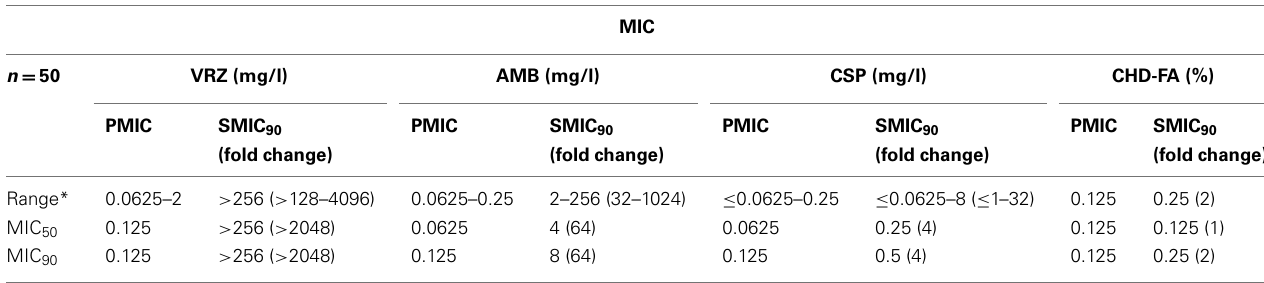
Table 1 | Susceptibility profile of Candida albicans to four antifungal